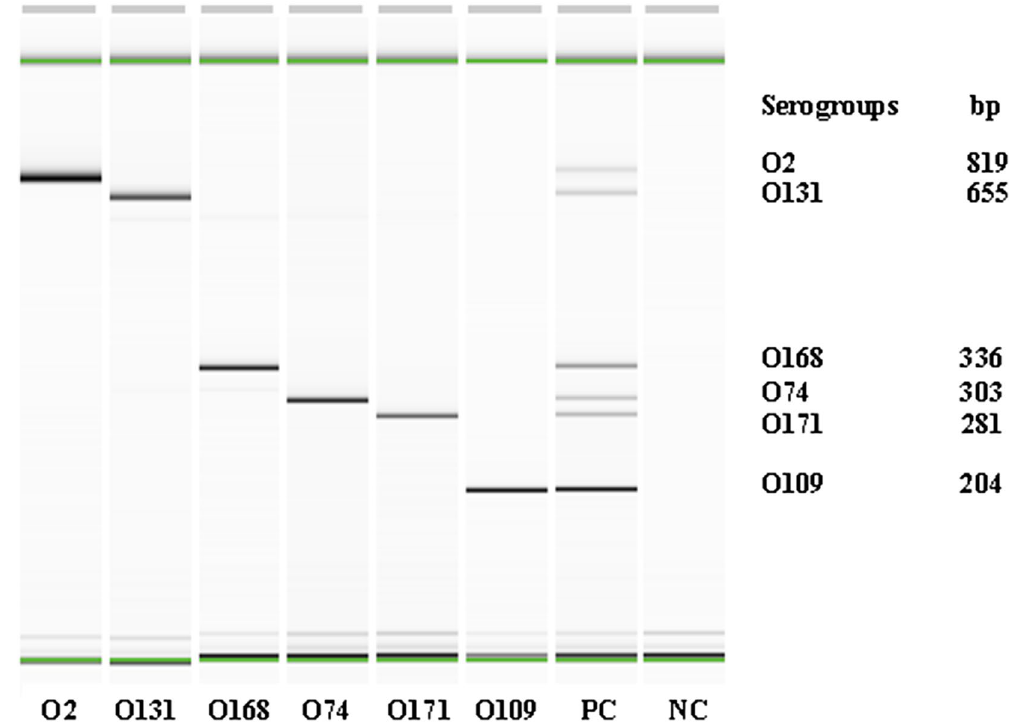
Figure 2. QIAxcel image of the amplicons of serogroup-specific genes of six individual and pooled Shiga toxin- producing Escherichia coli amplified by six-plex PCR assay (PC = Positive control [mixture of all 6 serogroups]); NC = Negative control).